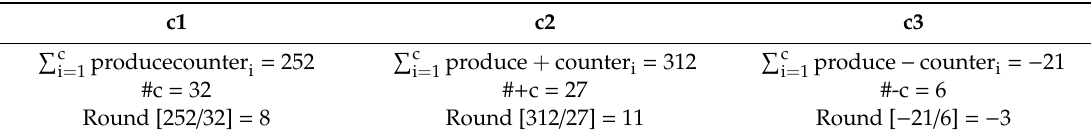
Table 4. Values of c1, c2 and